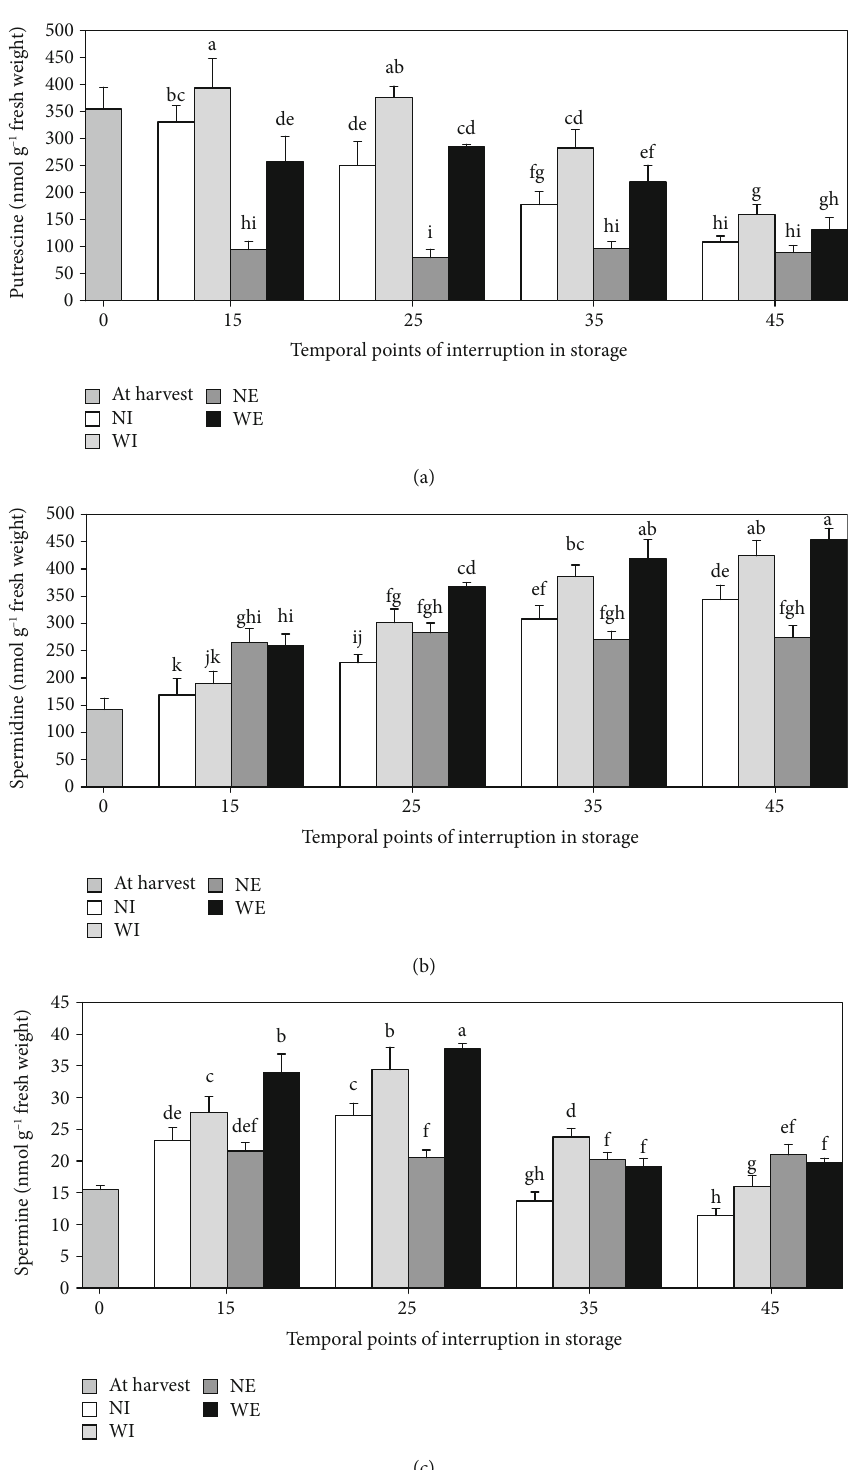
Figure 3: Modi fi cations in the content of putrescine (a), spermidine (b), and spermine (c) in pomegranate fruit peel during 70 days storage (at 2 ± 0.5 ° C and 90 ± 5% RH). Intermittent warming was conducted in the form of a single warming period (1 day at 20 ° C with 70% RH) before returning the treated fruit to storage. Temporal points of interruption were 15th, 25th, 35th, or 45th days of storage. WI stands for warmed fruit which were immediately sampled after warming on the date of interruption, NI stands for not warmed fruit which were sampled on the date of interruption, WE stands for warmed fruit, which were returned to storage and sampled at the end of the storage period, and NE stands for not warmed fruit sampled at the end of the storage period. Data are means of 3 replicates ± SD. All statistical di ff erences (by LSD test, P ≤ 0.05) throughout the storage period are shown in di ff erent